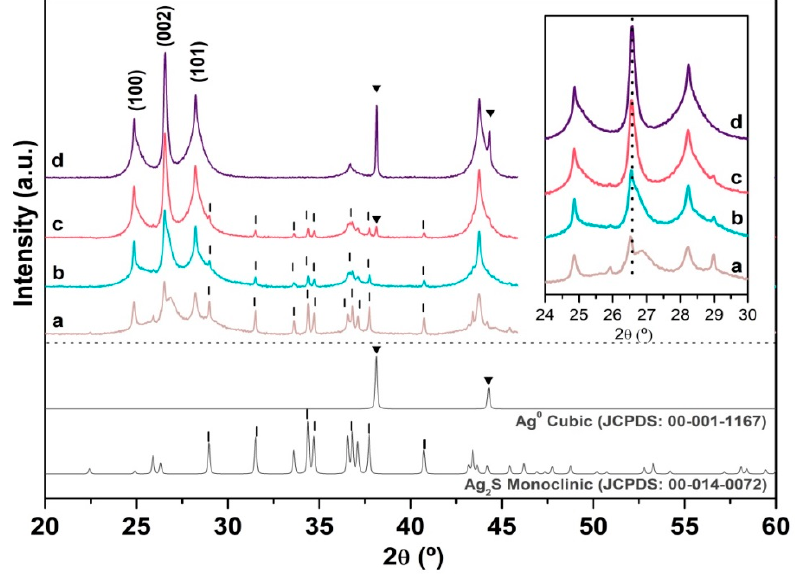
Figure 2. XRD patterns of AgCdS-T photocatalysts: ( a ) T = 90 ◦ C; ( b ) T = 120 ◦ C; ( c ) T = 150 ◦ C; and ( d ) T = 190 ◦ C. Table 2. Crystallite size and lattice strains of AgCdS-T photocatalytsts determined from XRD. Dp